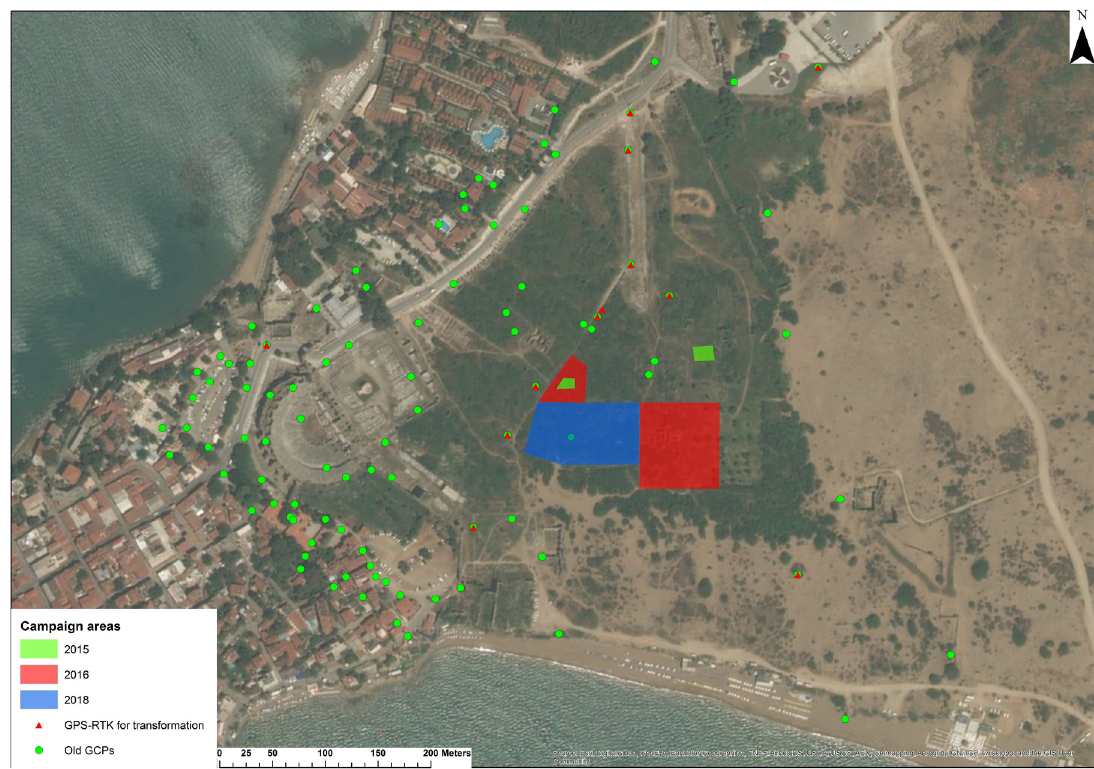
Figure 5. Campaign areas and GCPs used for transformation © ÖAW/IKAnt (M. Hernández